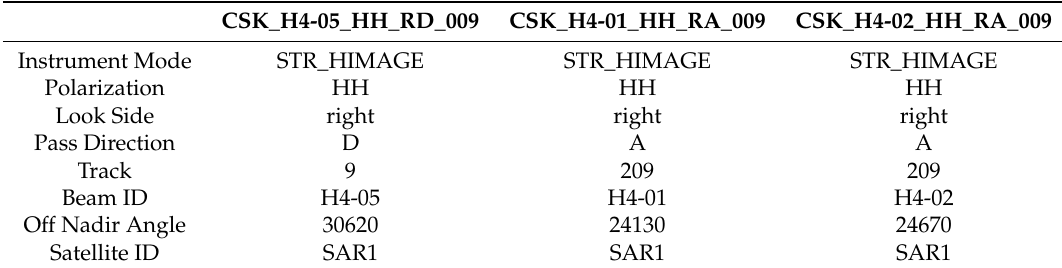
Table 2. COSMO-SkyMed (CSK) dataset